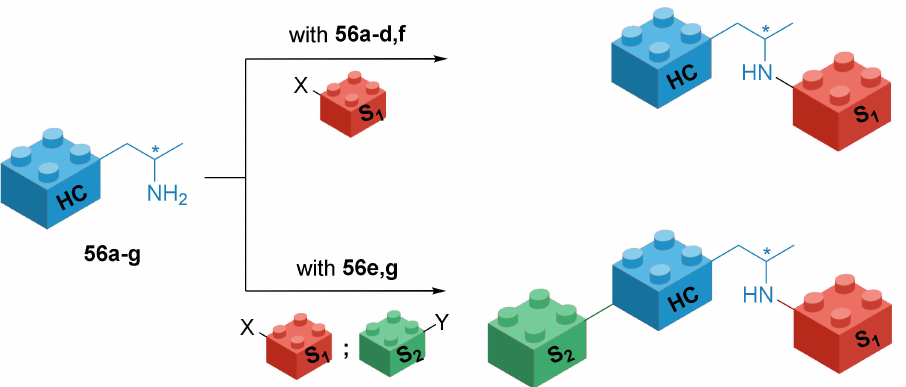
Figure 15. Applicability of potential drug scaffold chiral amines [( S )- or ( R )- 55a–g ] with 3D heterocyclic units ( HC ) as building blocks for the preparation of enantiopure